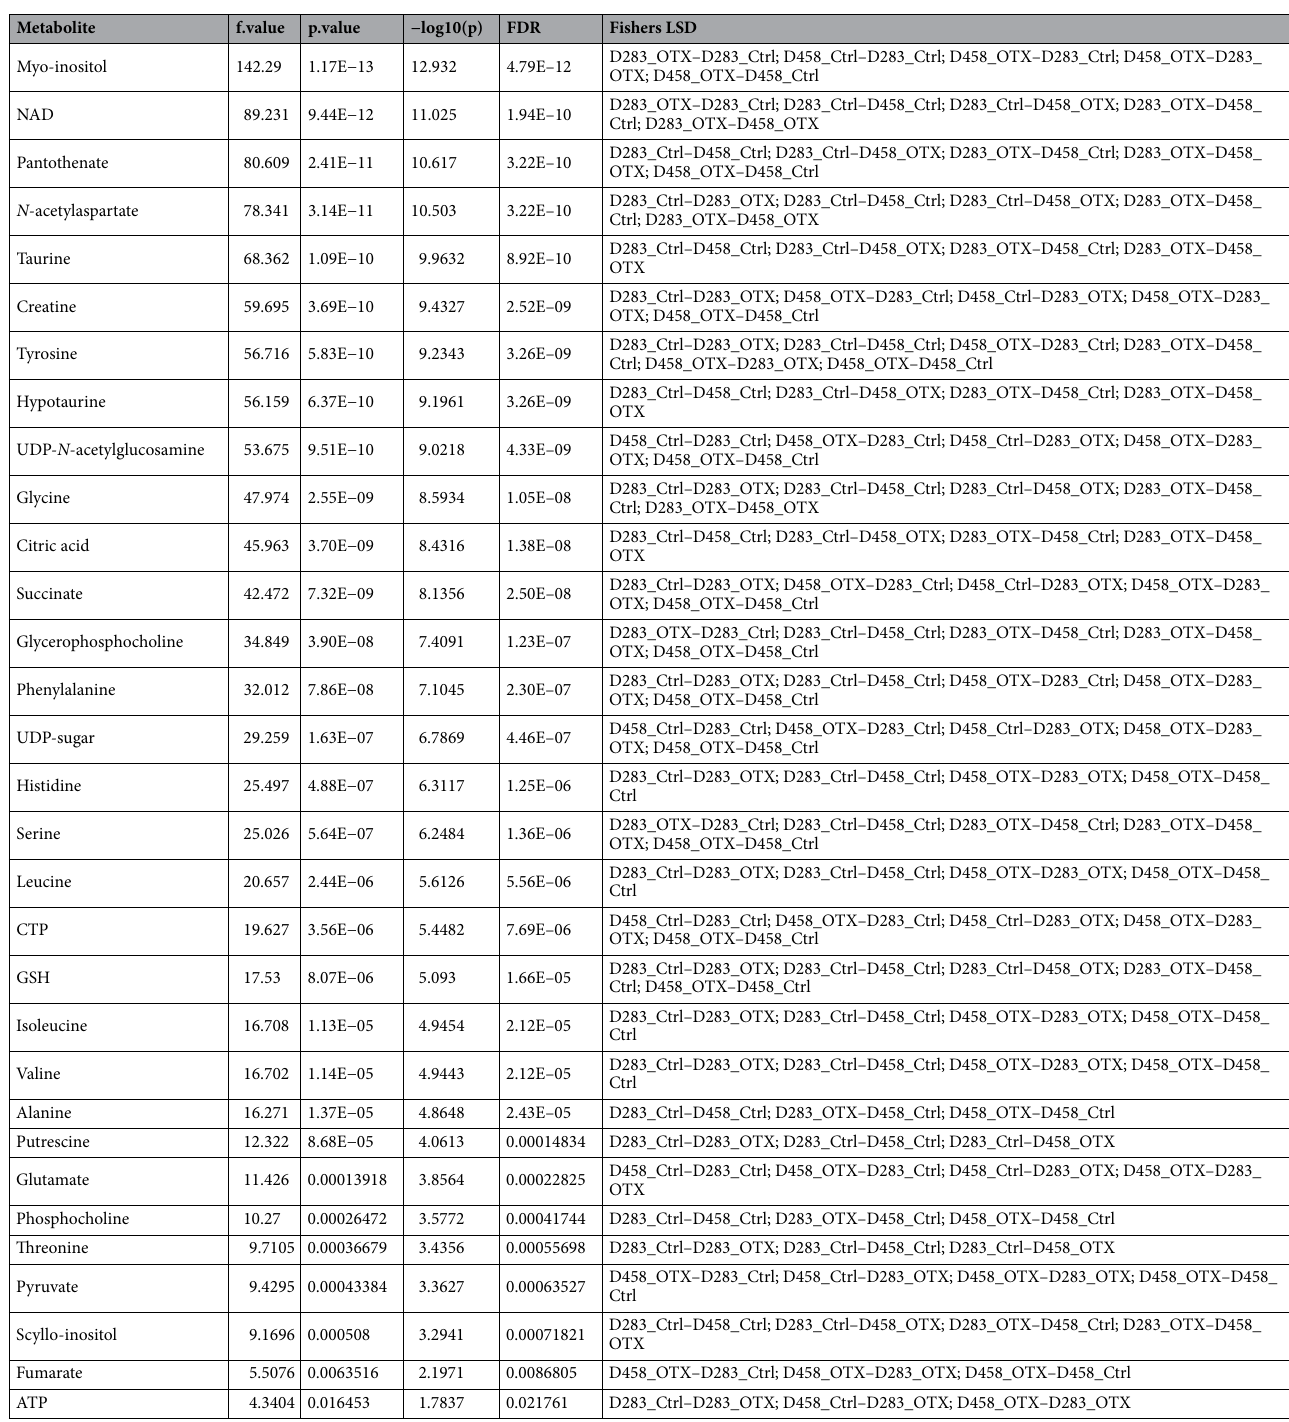
Table 1. Features identified by one-way ANOVA and post hoc analysis using Metaboanalyst 5.0. Fisher’s least significant difference (LSD) shows significant pairwise comparisons of the conditions under